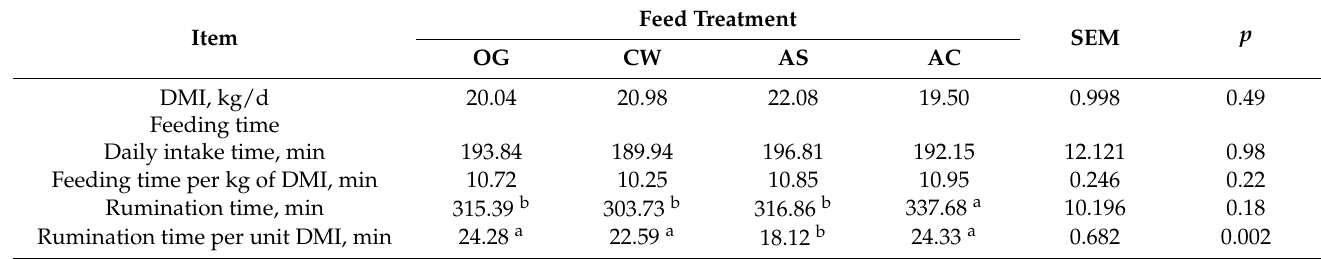
Table 3. Effects of dietary treatments on DMI, feed intake and rumination time 2 .